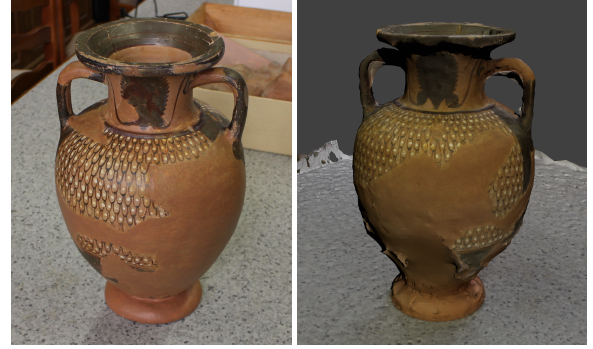
Figure 8. An example of 3D model reconstruction of an ancient vase using matches found by the WIZARD descriptor